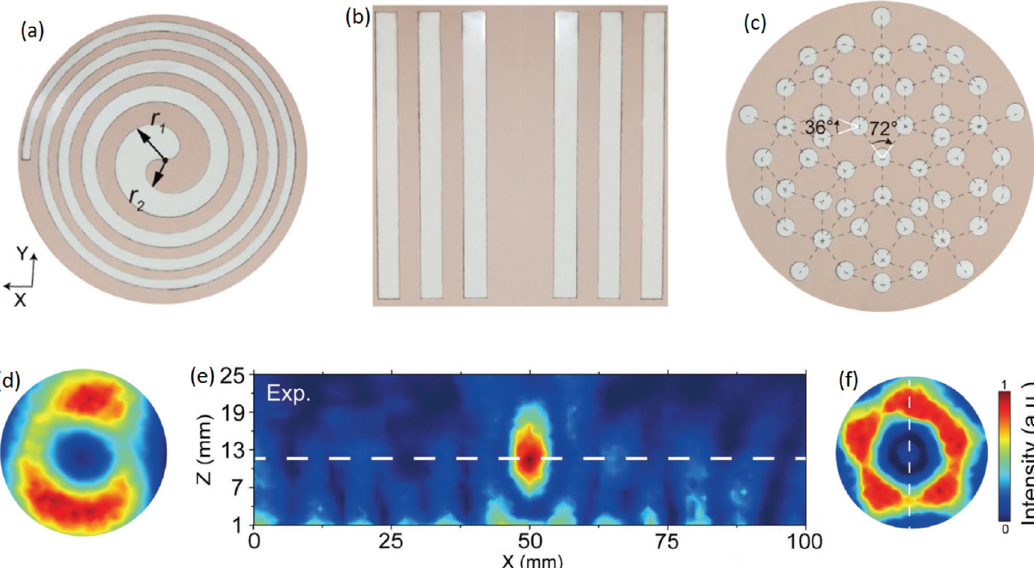
Fig. 6. AMS devices and the corresponding measured fi elds. Photograph of the hollow-out patterning metasurface with (a) Fermat spiral, (b) stripe, and (c) Penrose-like. Experimental intensity fi eld generated (d) Fermat spiral patterned vortex in x – y plane at z =8 mm, (e) stripe-patterned focusing in x – z plane, and (f) Penrose-like patterned super-oscillation in x – y plane at z = 34mm.